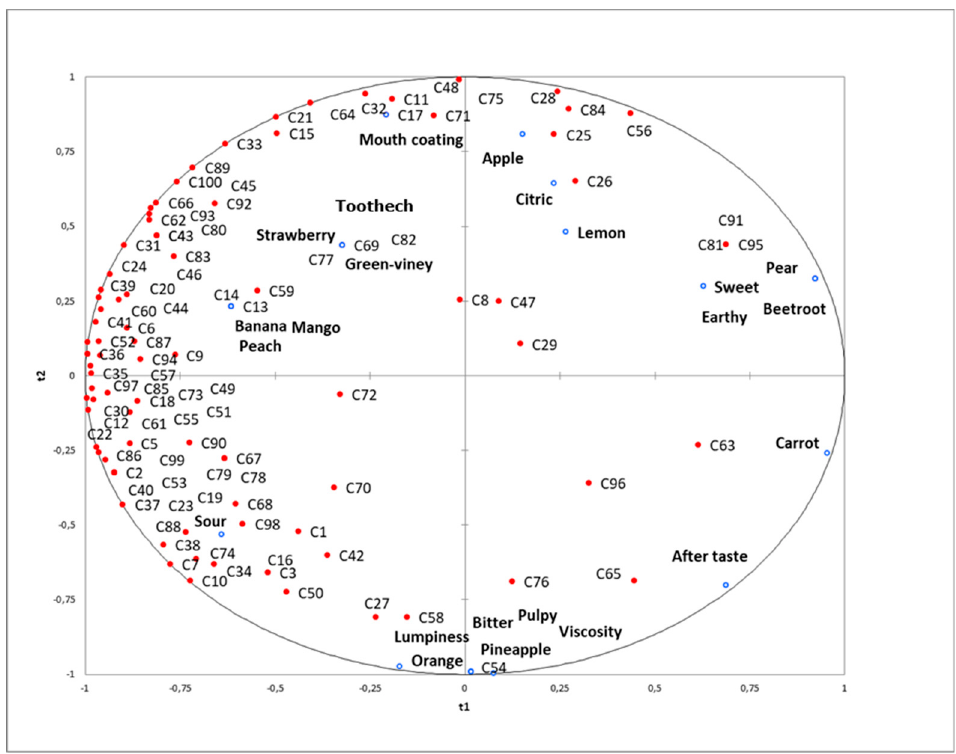
Figure 3. Partial least squares regression (PLS) of the descriptive sensory profile (Y) and consumer overall liking (X) of selected commercial smoothies.